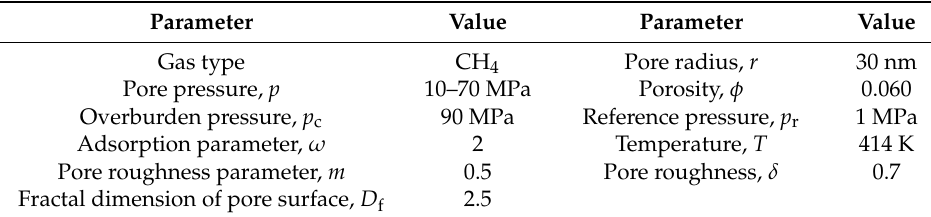
Table 6. Input parameters of gas and formation for model analysis.